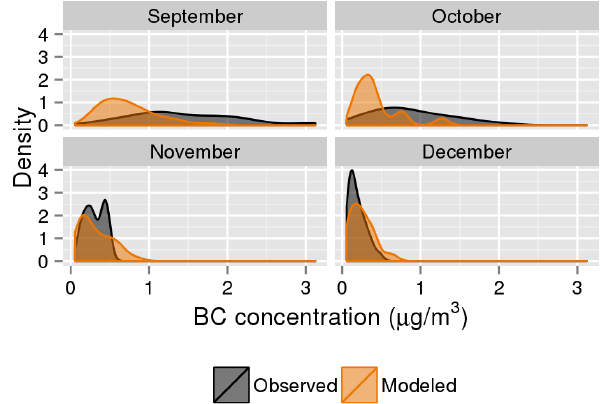
Figure 6. BC concentrations at Welgegund, measured and mod- eled with WRF-Chem: probability density functions (PDFs) for September–December 2010. The PDFs are calculated from the ob- served 15-min values and the 3-hourly values (instantaneous values) from the model